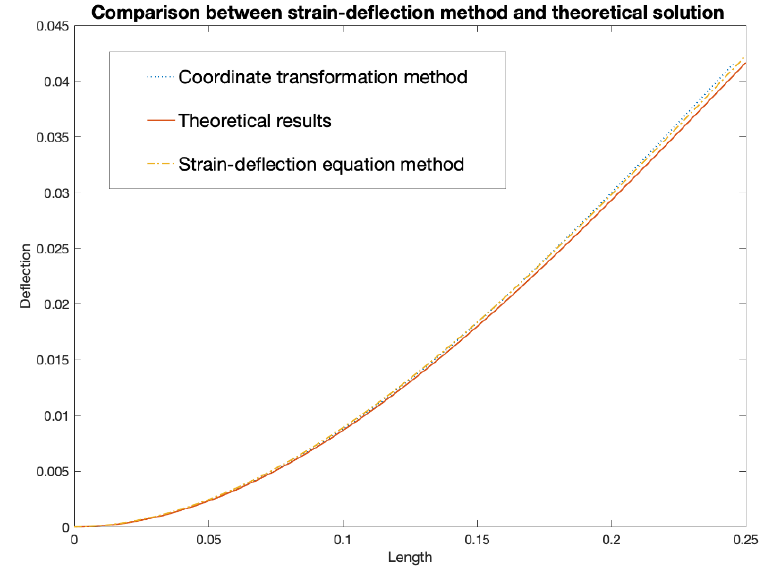
Figure 12. Comparison between CTM and SDEM algorithms.